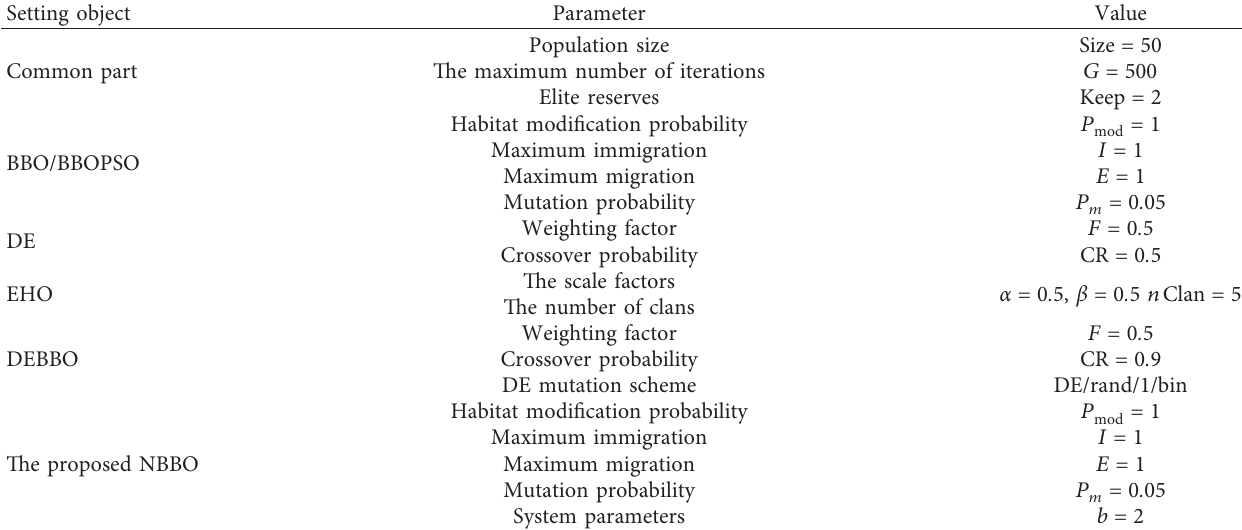
Table 2: Algorithm parameter